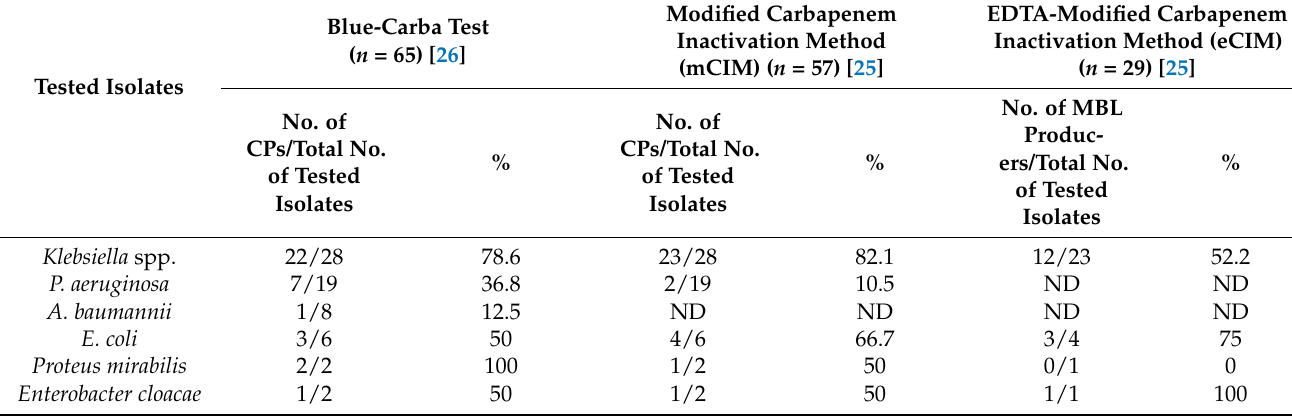
Table 4. Phenotypic detection of carbapenemase production in carbapenem-resistant Gram-negative bacterial isolates.